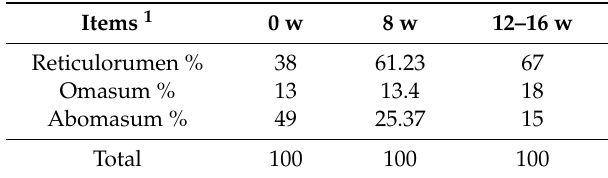
Table 1. The development of the